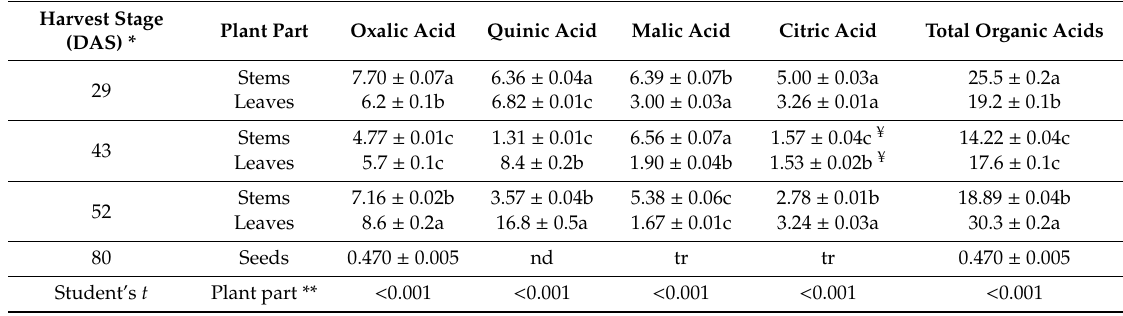
Table 3. Composition in organic acids (g / 100 g fw) of purslane stems and leaves in relation to harvesting stage (mean ±